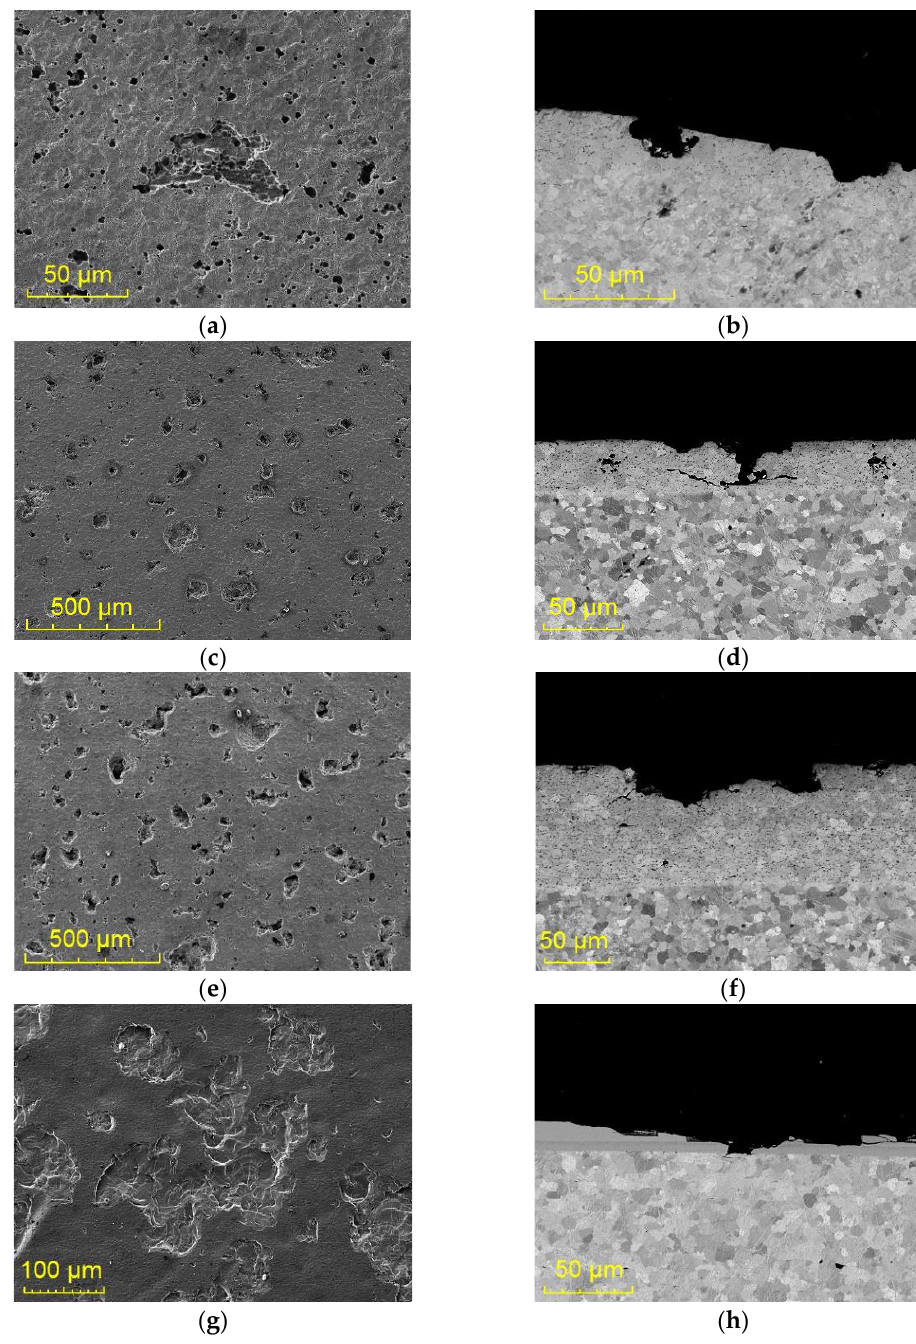
Figure 10. Representative view of destruction under droplet impact for 600 min ( d k = 150 μ m S imp = 250 m/s) of 20Kh13 steel with nitriding type I ( a , b ), with nitriding type II ( c , d ), with nitriding type III ( e , f ), with Cr – CrC based coating ( g , h ).